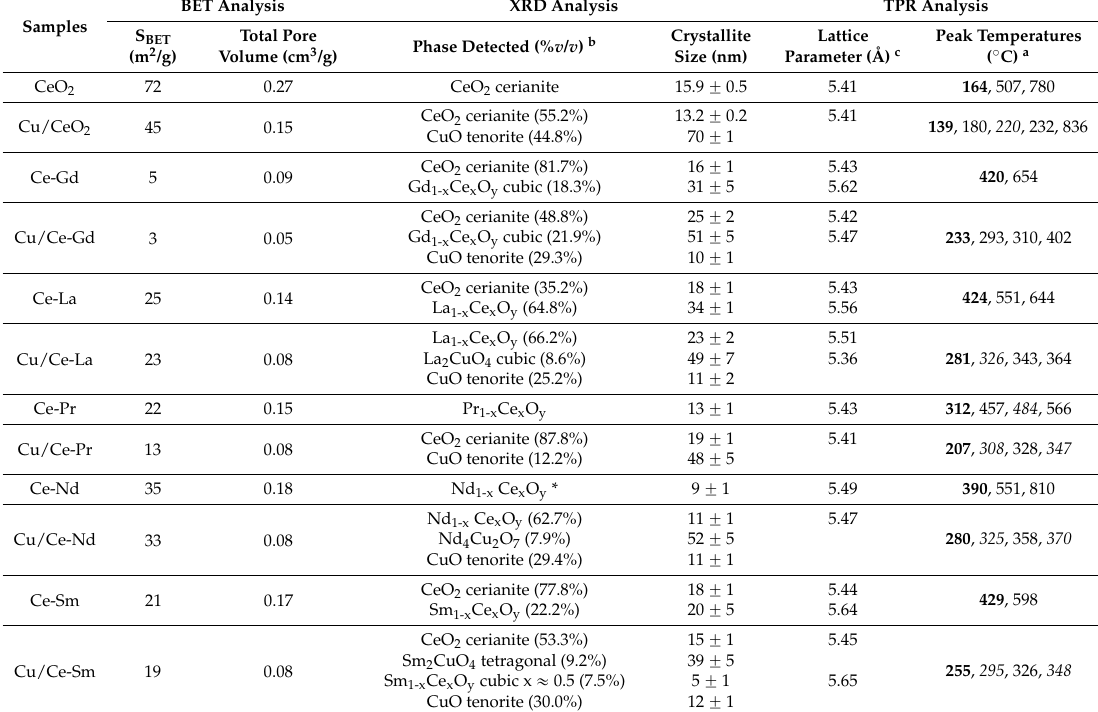
Table 1. Main physicochemical characteristics of Ce-Ln and Cu/Ce-Ln materials (Ln: Gd, La, Pr, Nd, Sm) obtained by BET, XRD and TPR analyses. Onset temperature of H 2 -TPR peaks is shown in bold, peak maxima in plain text and peak shoulders in